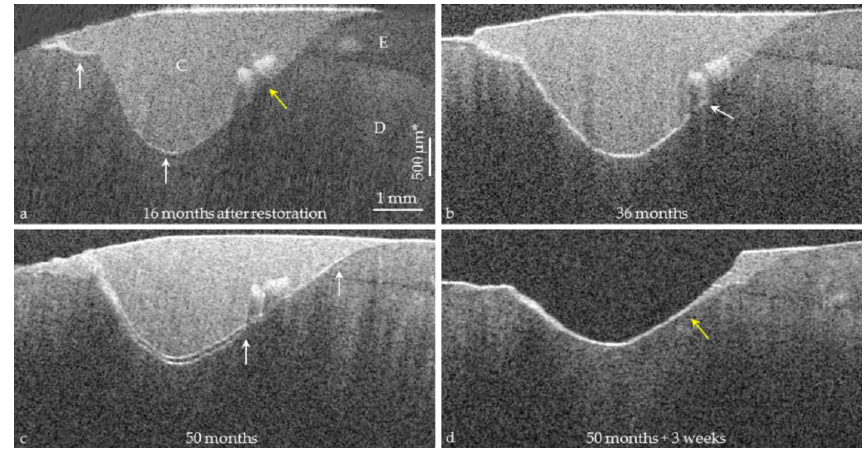
Figure 22. In vivo monitoring of the tooth ‐ composite bond using SD ‐ OCT. ( a ) A cervical composite restoration (C) at premolar 34, sixteen months after restoration. The cavity was filled in increments. The composite contains imperfections (yellow arrow). The bright line marks an extensive adhesive defect (white arrows) at dentin (D). ( b , c ) The same cross ‐ section imaged using OCT in the period up until 50 months; the interfacial gap has progressed (bright line, white arrows), but there are no signs of secondary caries. ( d ) Three weeks later, the restoration failed. The imperfection has probably acted as a hinge (yellow arrow). At enamel (E) this saved the composite from loss. * Vertical bar is related to refractive index n = 1.5.